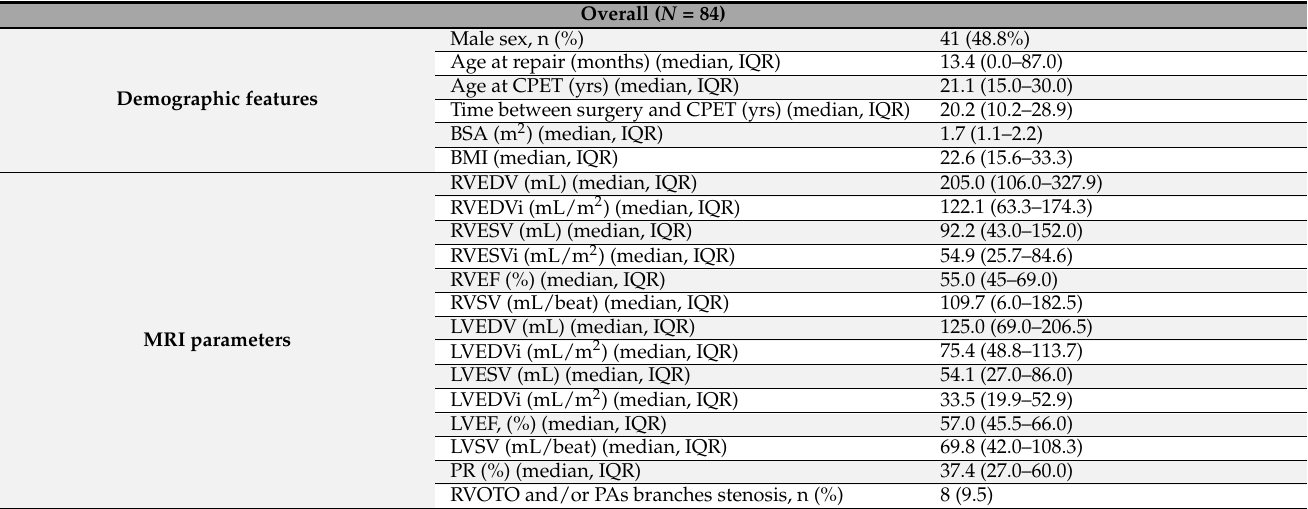
Table 1. Characteristics of 84 rToF patients. Data are expressed as median values and interquartile ranges for continuous variables and as counts and percentages for categorical